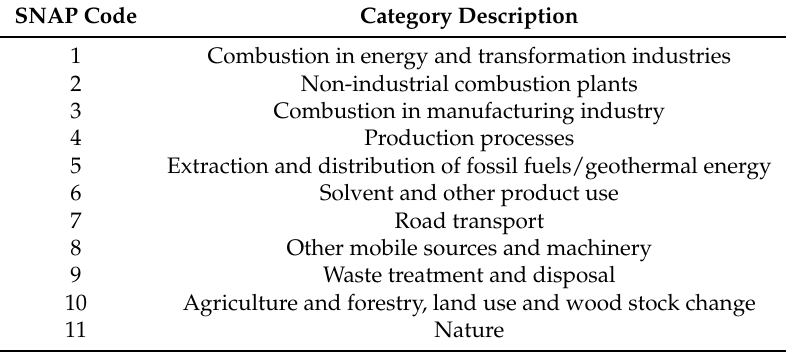
Table A1. The 11 main CORINAIR